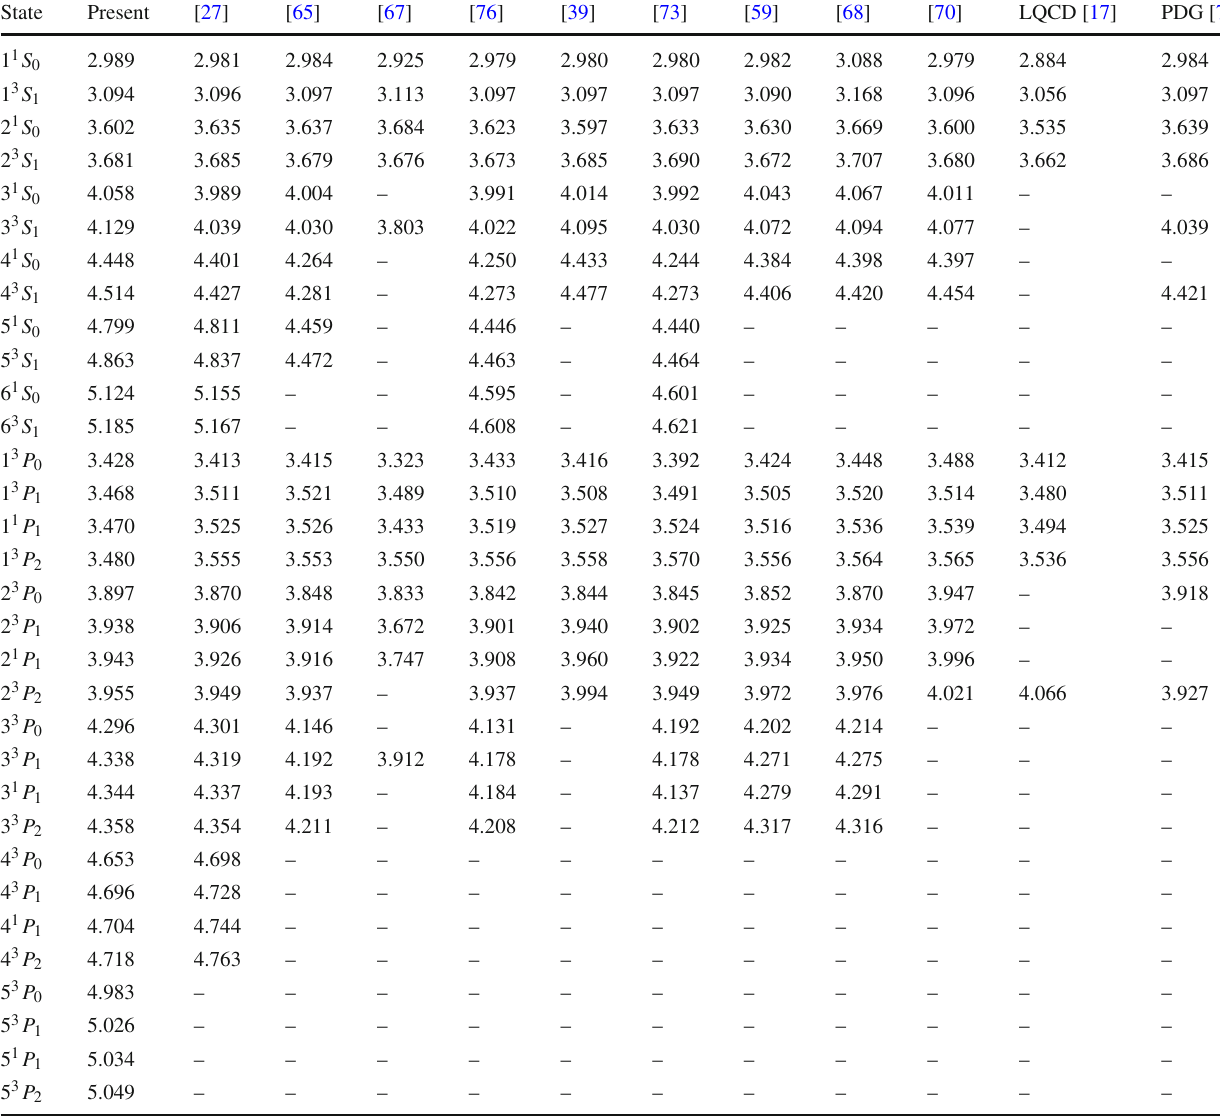
Table 2 Mass spectrum of S and P -wave charmonia (in GeV)